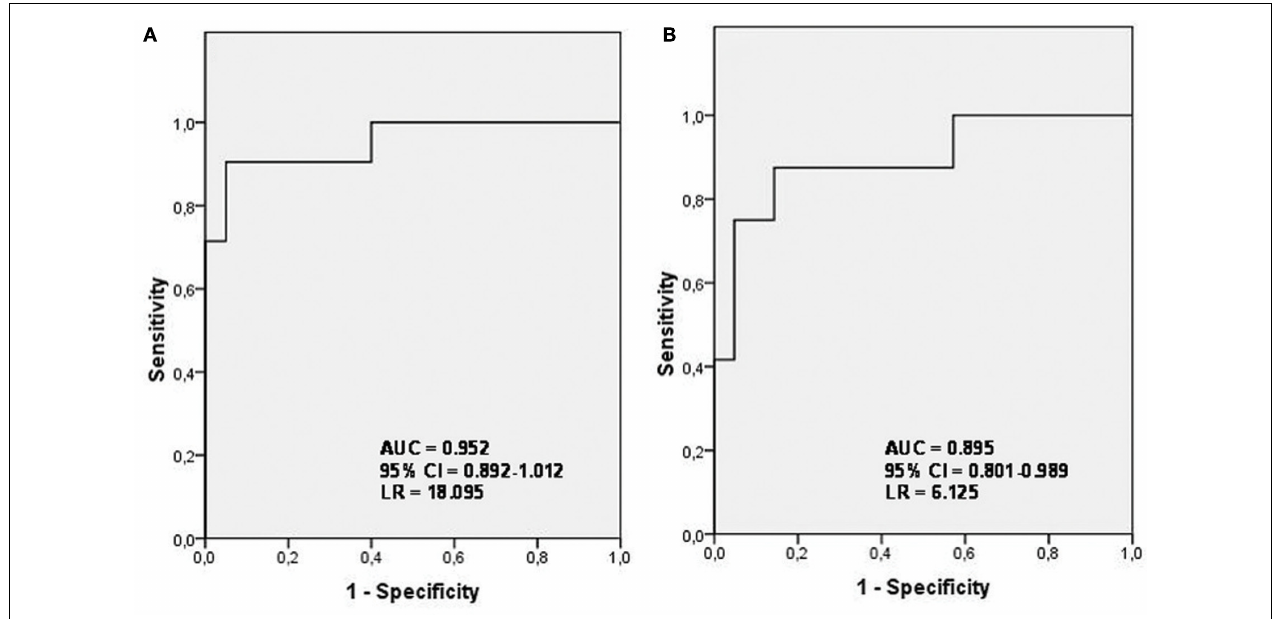
ROC curve from the regression model for diagnosis in haplogroup J carriers. (AUC, area under the curve; CI, confidence interval; LR, likelihood